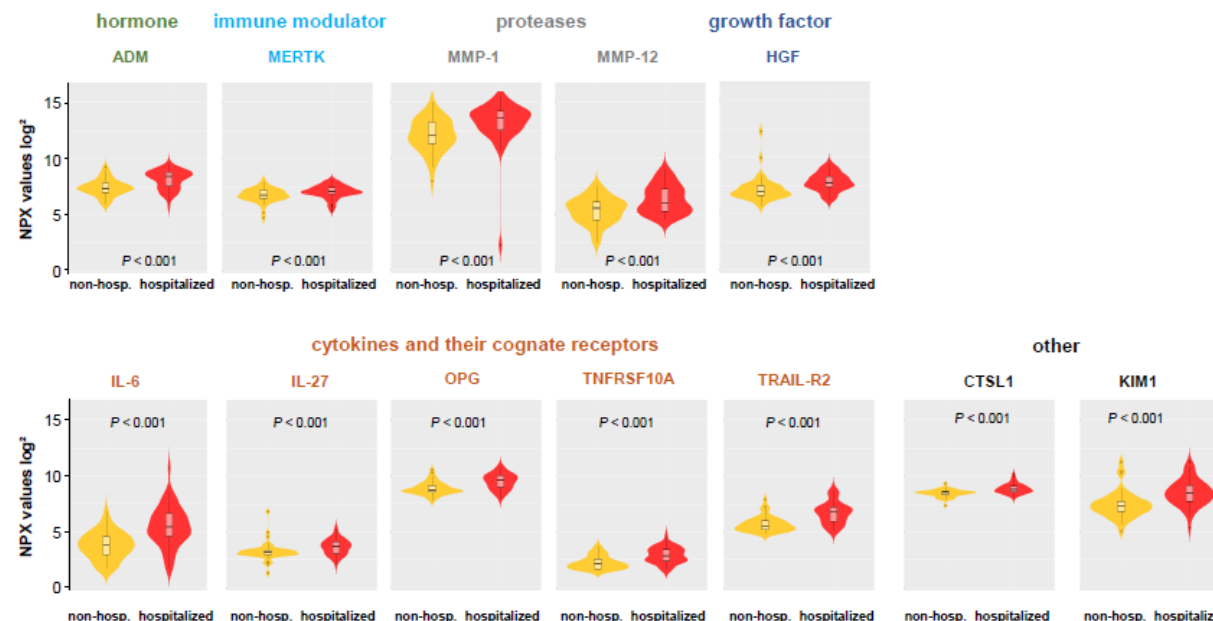
Figure 4. Proteome analyses—PEA values of discriminatory analytes within COVID-19 group, either non-hospitalized (outpatients) or hospitalized (inpatients). Data are visualized by violin plots, which are a combination of kernel density plots, and box plots depicting median, 25th and 75th percentiles. A high-normalized protein expression (NPX) value resembles a high protein concentration and expresses the relative quantification between samples. NPX values are given on a log-scale. Yellow = COVID-19 without hospitalization; red = COVID-19 with hospitalization; black dots: outliers.